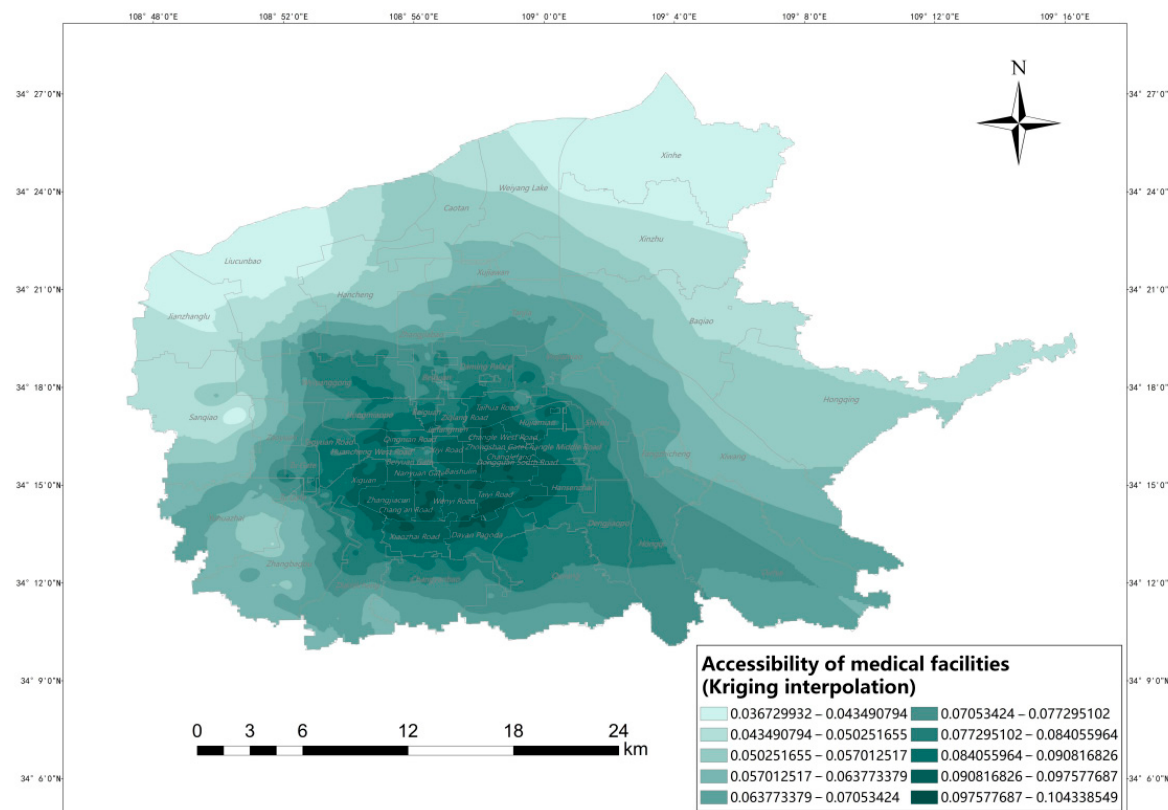
Figure 9. Accessibility of medical facilities (Kriging interpolation).